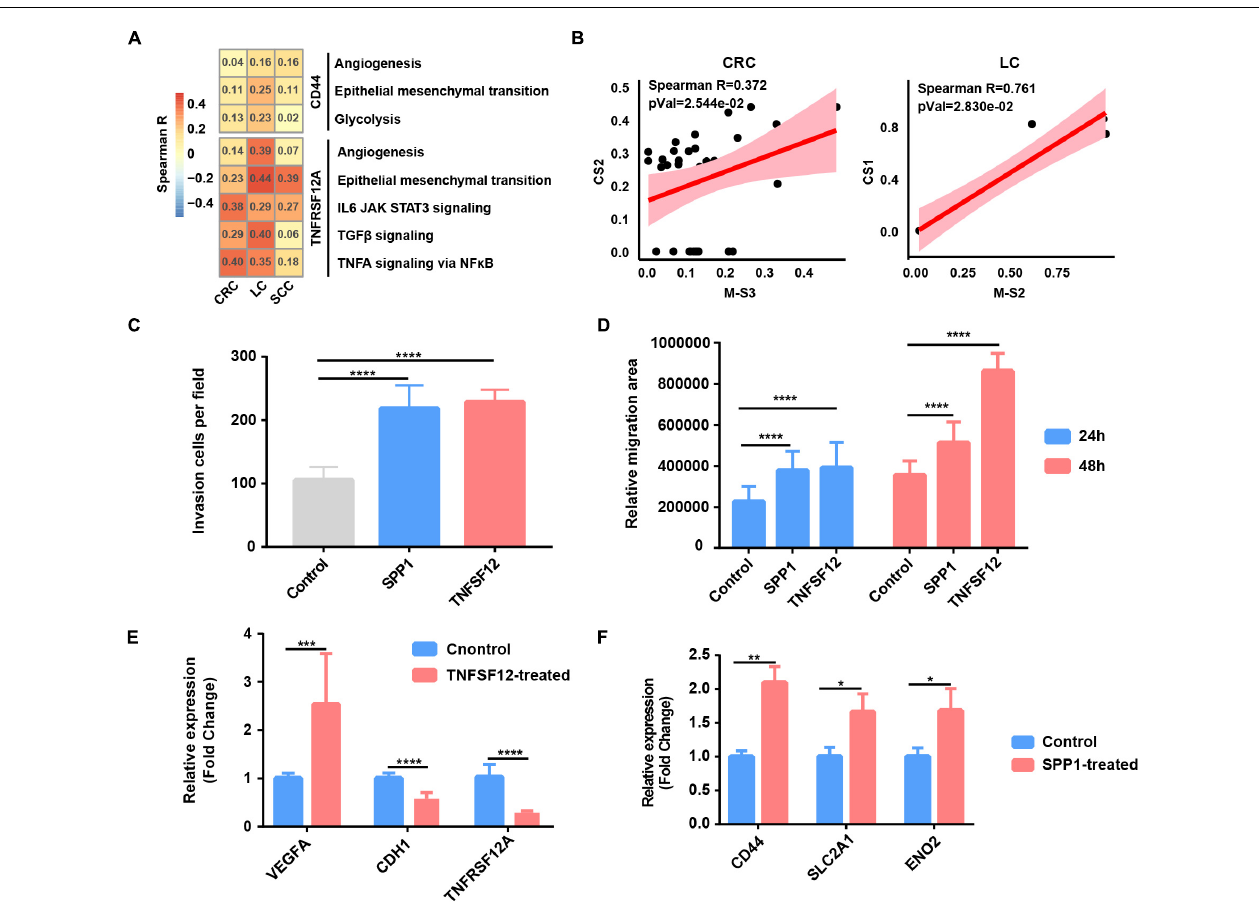
FIGURE 5 | Tumor-associated macrophages (TAMs) promote glycolysis, invasion, and migration phenotype of cancer cells. (A) Heatmap depicts the correlation between CD44 or TNFRSF12A expression and hallmark signatures scores in cancer cells. (B) The correlation between proportional changes in SPP1+ TAM cluster (M-S3 and M-S2 in CRC and LC, respectively) and epithelial–mesenchymal transition (EMT)-related cancer cells (CS2 and CS1 in CRC and LC, respectively). (C) Box plot shows relative invasion cells per field of A549 cells treated by recombinant protein SPP1 and TNFSF12 for 24 and 48 h. **** p ≤ 0.0001, two-sided unpaired t -test. (D) Box plot shows relative migration area of A549 cells treated by recombinant protein SPP1 and TNFSF12 for 24 and 48 h. **** p ≤ 0.0001, two-sided unpaired t -test. (E) Relative mRNA expression of specific genes ( VEGFA , CDH1 , and TNFRSF12A ) in A549 lung cancer cells exposed to TNFSF12 for 48 h. ** p ≤ 0.01, two-sided unpaired t -test. (F) Relative mRNA expression of specific genes ( CD44 , SLC2A1 , and ENO2 ) in A549 lung cancer cells exposed to SPP1 for 48 h. * p ≤ 0.05; ** p ≤ 0.01, two-sided unpaired t